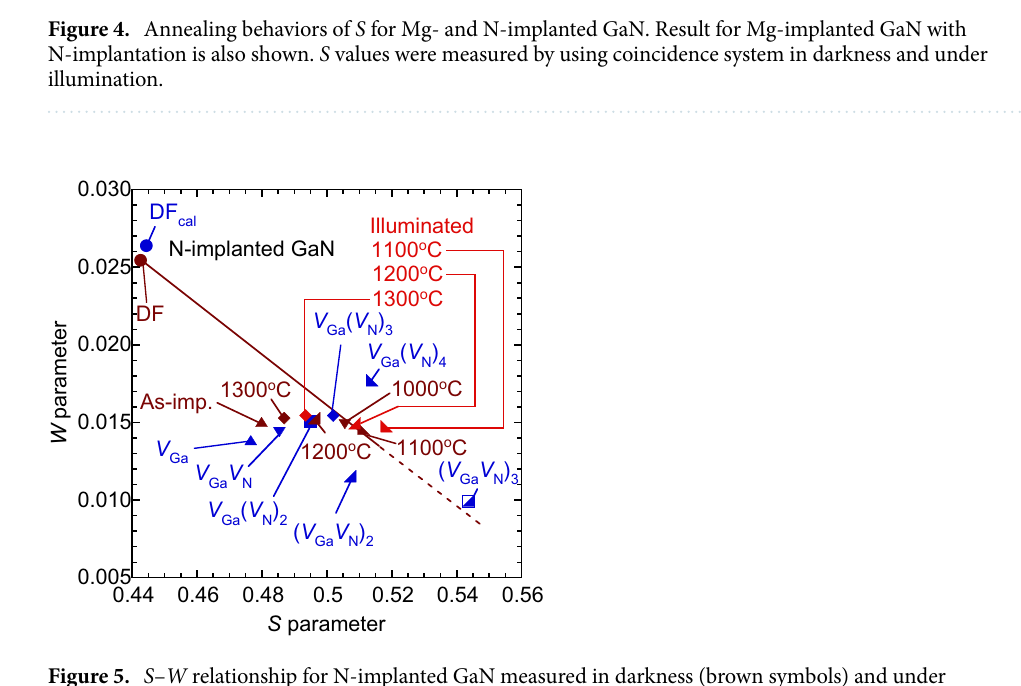
Figure 5. S – W relationship for N-implanted GaN measured in darkness (brown symbols) and under illumination (pink), where annealing temperatures are shown in figure. ( S , W ) for unimplanted GaN is shown as “DF.” Calculated values for positron annihilation in defect-free GaN (DF cal ), V Ga , V Ga ( V N ) n (n = 1–4), ( V Ga V N ) 2 , and ( V Ga V N ) 3 are also shown (blue